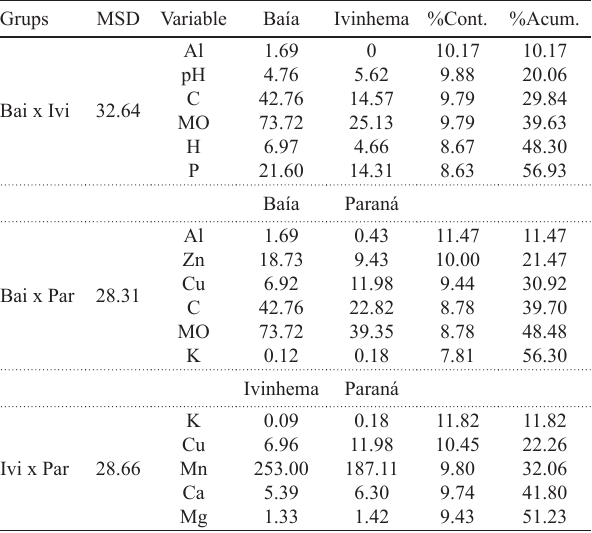
Table 1. SIMPER analysis for chemical composition and organic matter in the sediment of the Upper Paraná River floodplain. MSD = mean square distance. %Cont. = percentage of individual contribution of each variable. %Acum. = percentage of accumulated contribution of the variables. pH = hydrogenionical potential, H + = total hydrogen (cmolc/dm 3 ), MO = organic matter (g/dm 3 ), C = carbon (g/dm 3 ), P = phosphorus (g/dm 3 ), K = potassium (g/ dm 3 ), Ca = calcium (g/dm 3 ), Mg = magnesium (g/dm 3 ), Al = aluminum (g/dm 3 ), Cu = copper (g/dm 3 ), Zn = zinc (g/ dm 3 ) and Mn = manganese (g/dm 3 ).